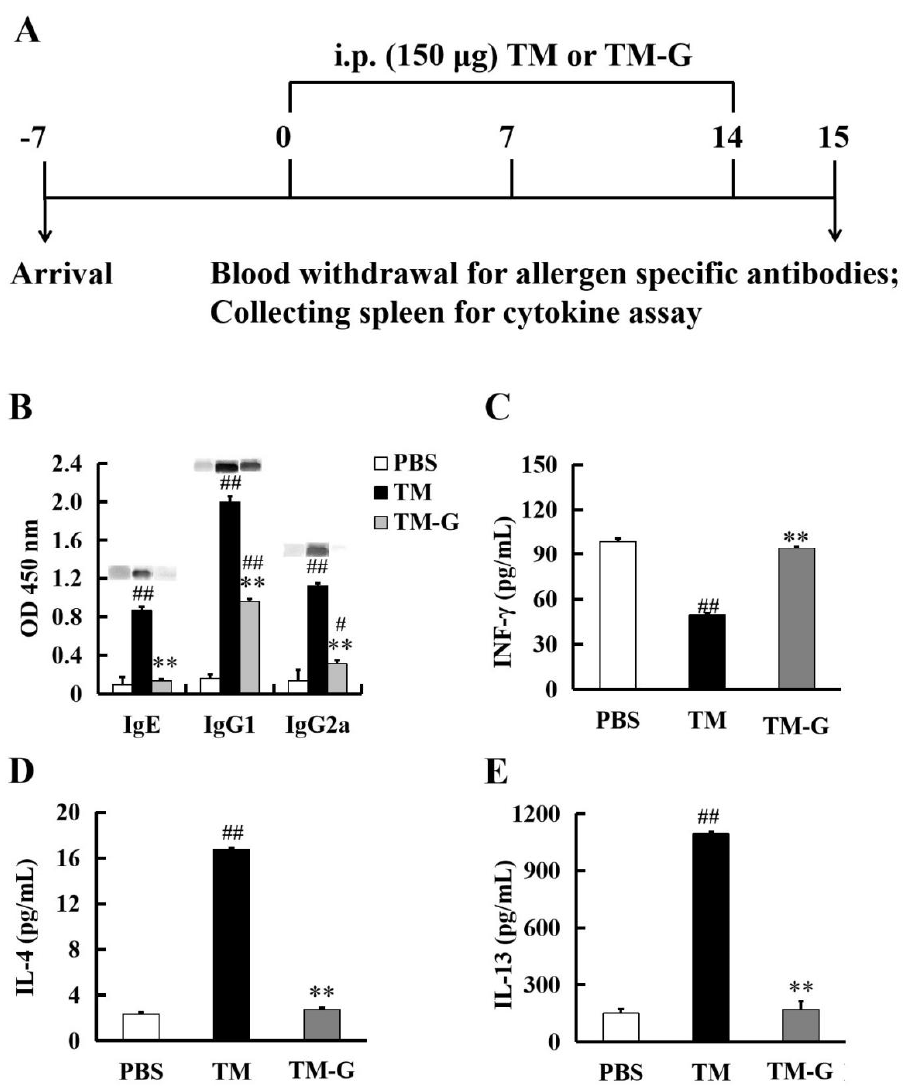
Figure 4. Sensitizing potential of TM-G: ( A ) Experimental design of in vivo sensitization. ( B ) Serum levels of IgE, IgG1, and IgG2a. ( C – E ) IFN- γ , IL-4, and IL-13 production by individual spleen lymph cells, was evaluated by ELISA in culture supernatants. All data are presented as the mean ± SD ( n = 3). ## p < 0.01 was used to compare with PBS group. ** p < 0.01 was used to compare with the TM group.